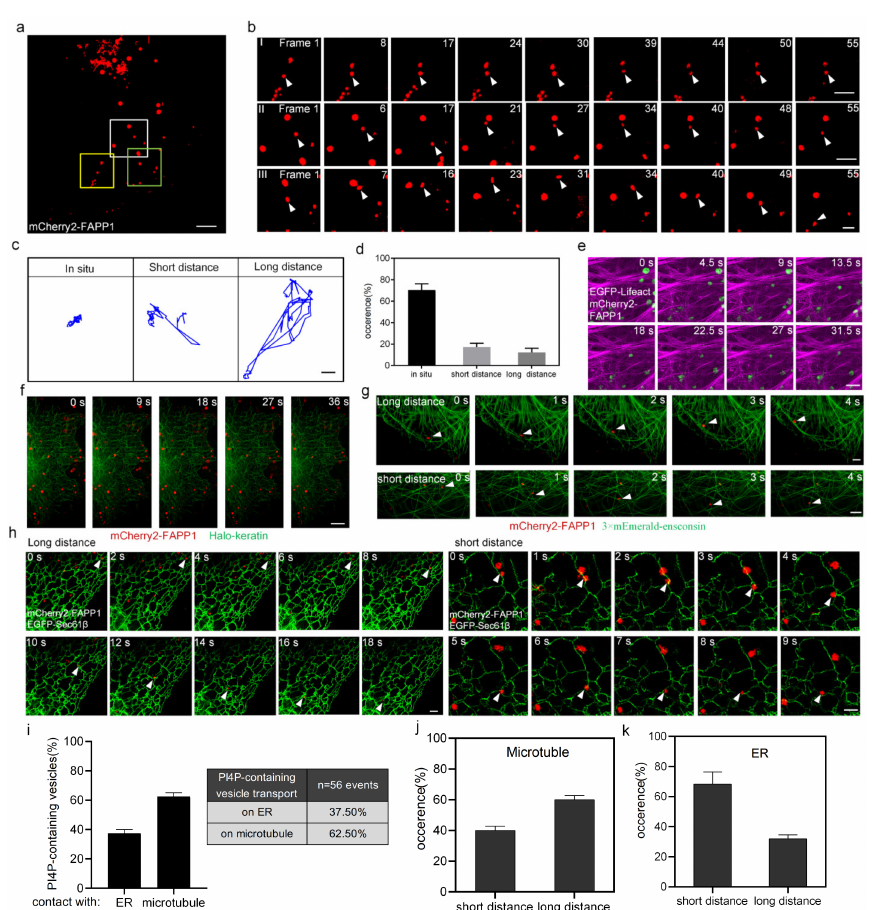
Figure 2. The ER and microtubules facilitate the intracellular transport of PI4P-containing vesicles. ( a ) SIM image of PI4P-containing vesicles (tagged with mCherry2-FAPP1, red) in live U-2 OS cells. Scale bar: 5 µ m. ( b ) Boxed regions of interest shown in a are presented at the indicated time points to exemplify in situ, short-distance and long-distance transport. I is the region in the yellow box, II is the region in the white box, and III is the region in the green box. Scale bar: 2 µ m. ( c ) Left panel, the trajectory of in situ PI4P vesicle transport; middle panel, the trajectory of short-distance PI4P vesicle transport; right panel, the trajectory of long-distance PI4P vesicle transport. ( d ) Histograms showing the percentage of the three kinds of PI4P-containing vesicle transport—in situ, short-distance and long-distance—as determined with 500 PI4P-containing vesicles in 10 cells. ( e ) SIM images showing PI4P-containing vesicles (tagged with mCherry2-FAPP1, green) and microfilaments (tagged with EGFP-Lifeact, magenta) in live U-2 OS cells. Scale bar: 2 µ m. ( f ) SIM images of PI4P-containing vesicles (tagged with mCherry2-FAPP1, red) and intermediate filaments (tagged with Halo-keratin, green) in live U-2 OS cells. Scale bar: 5 µ m. ( g ) SIM images of PI4P-containing vesicles (tagged with mCherry2-FAPP1, red) and microtubules (tagged with 3 × mEmerald-ensconsin, green) in live U-2 OS cells. On the top, white arrows indicate the short-distance PI4P vesicle transport along microtubules; on the bottom, white arrows indicate the long-distance PI4P-containing vesicle transport along microtubules. Scale bar: 2 µ m. ( h ) SIM images of PI4P-containing vesicles (tagged with mCherry2- FAPP1, red) and the ER (tagged with EGFP-Sec61 β , green) in live U-2 OS cells. On the left, white arrows indicate the long-distance PI4P-containing vesicle transport along the ER; on the right, white arrows indicate short-distance PI4P vesicle transport along the ER. Scale bar: 2 µ m. ( i ) Quantitative statistics of the relative localization of the PI4P-containing vesicles and the ER or microtubules and the transport events between the PI4P-containing vesicles and the ER or microtubules. ( j , k ) Histograms showing the percentage of short-distance and long-distance PI4P-containing vesicle transport along microtubules (on the left) and the ER (on the